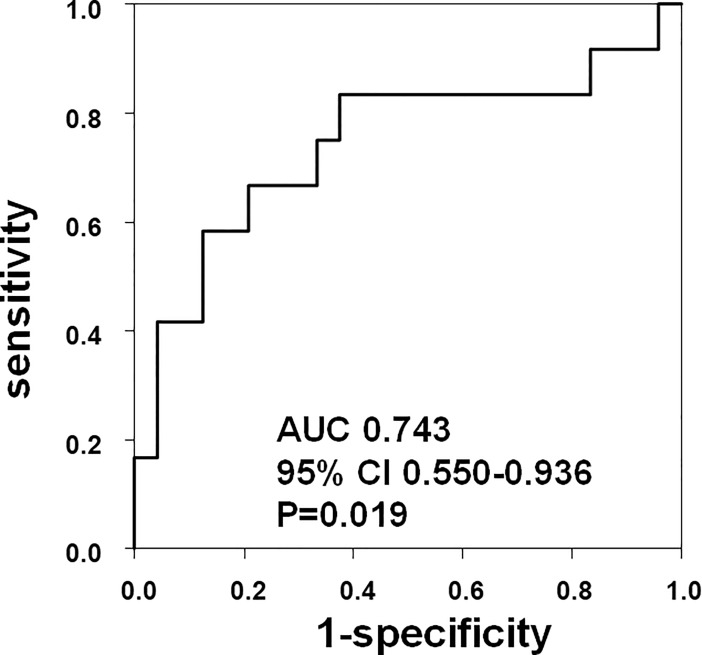
Receiver operating characteristic (ROC) curve for tricuspid regurgitation pressure gradient (TR-PG) for prediction of pulmonary hypertension (PH) in patients with chronic respiratory disease.As per the ROC curve, the sensitivity and specificity to detect PH defined by right heart catheterization were 58.3% and 87.5%, respectively, using the cut-off value as TR-PG = 40 mmHg. AUC, area under the curve; CI, confidence interval.